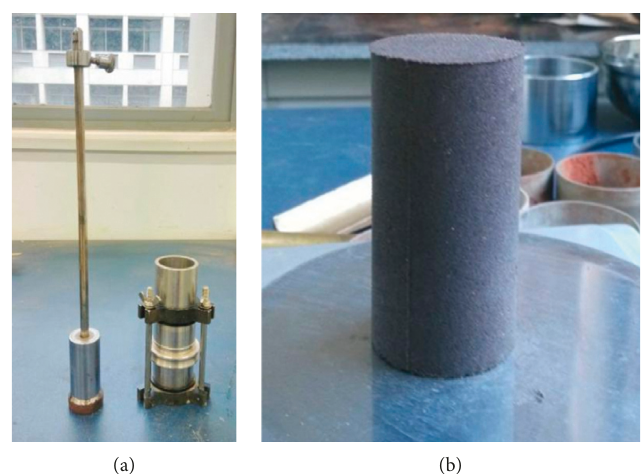
Figure 7: Compacted sand specimen: (a) compaction tool; (b) sand